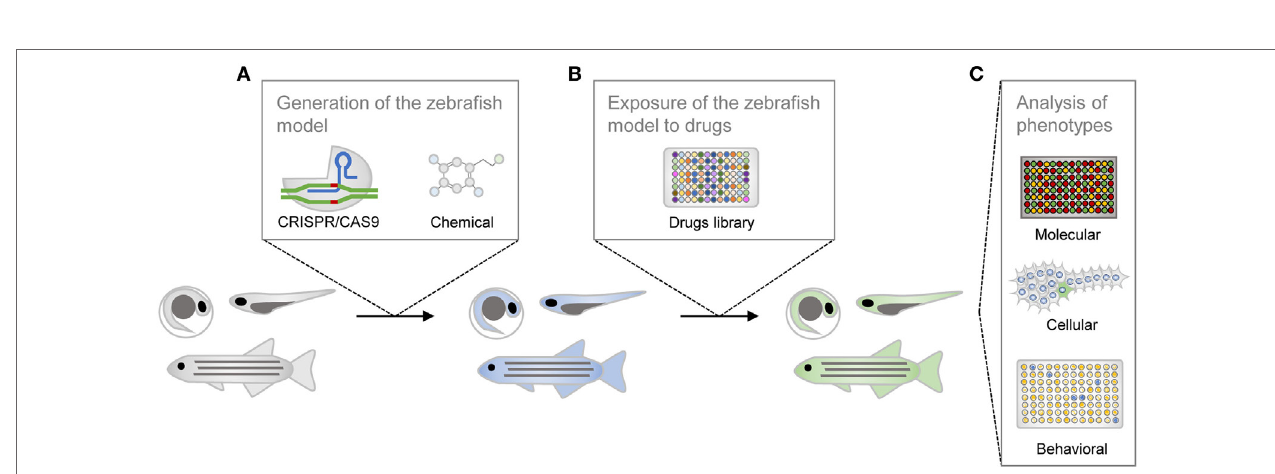
FiguRe 3 | Schematic representation of the drug screening process in zebrafish. The zebrafish line is generated with genetic or chemical tools (a) , is incubated with compounds from the library of small molecules (B) , and is then phenotypically characterized (c) .